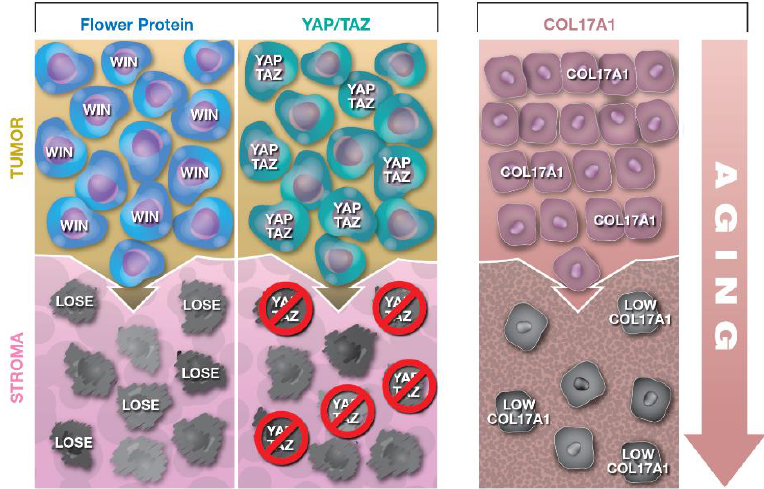
Figure 1. Illustration of cellular competition in cancer and aging skin. First column: hFWE win- expressing tumor cells outcompete adjacent stroma cells expressing hFWE loss. Second column: cells with a loss of YAP/TAZ expression in stroma cells are overtaken by YAP/TAZ abundant tumor cells. Third column: representation of epidermal stem cell competition in the context of COL17A1 expression. Low-COL17A1-expressing epidermal stem cells, which present characteristics of aged skin, are outcompeted by stem cells with higher COL17A1 expression.